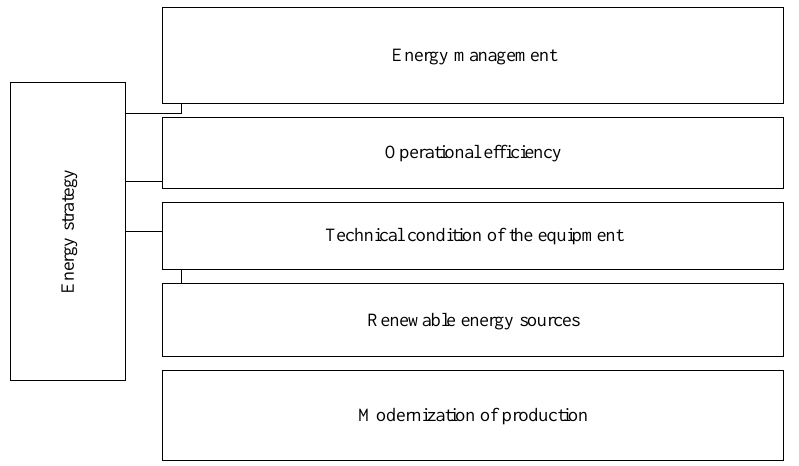
Figure 6. Key directions of the energy policy of industrial